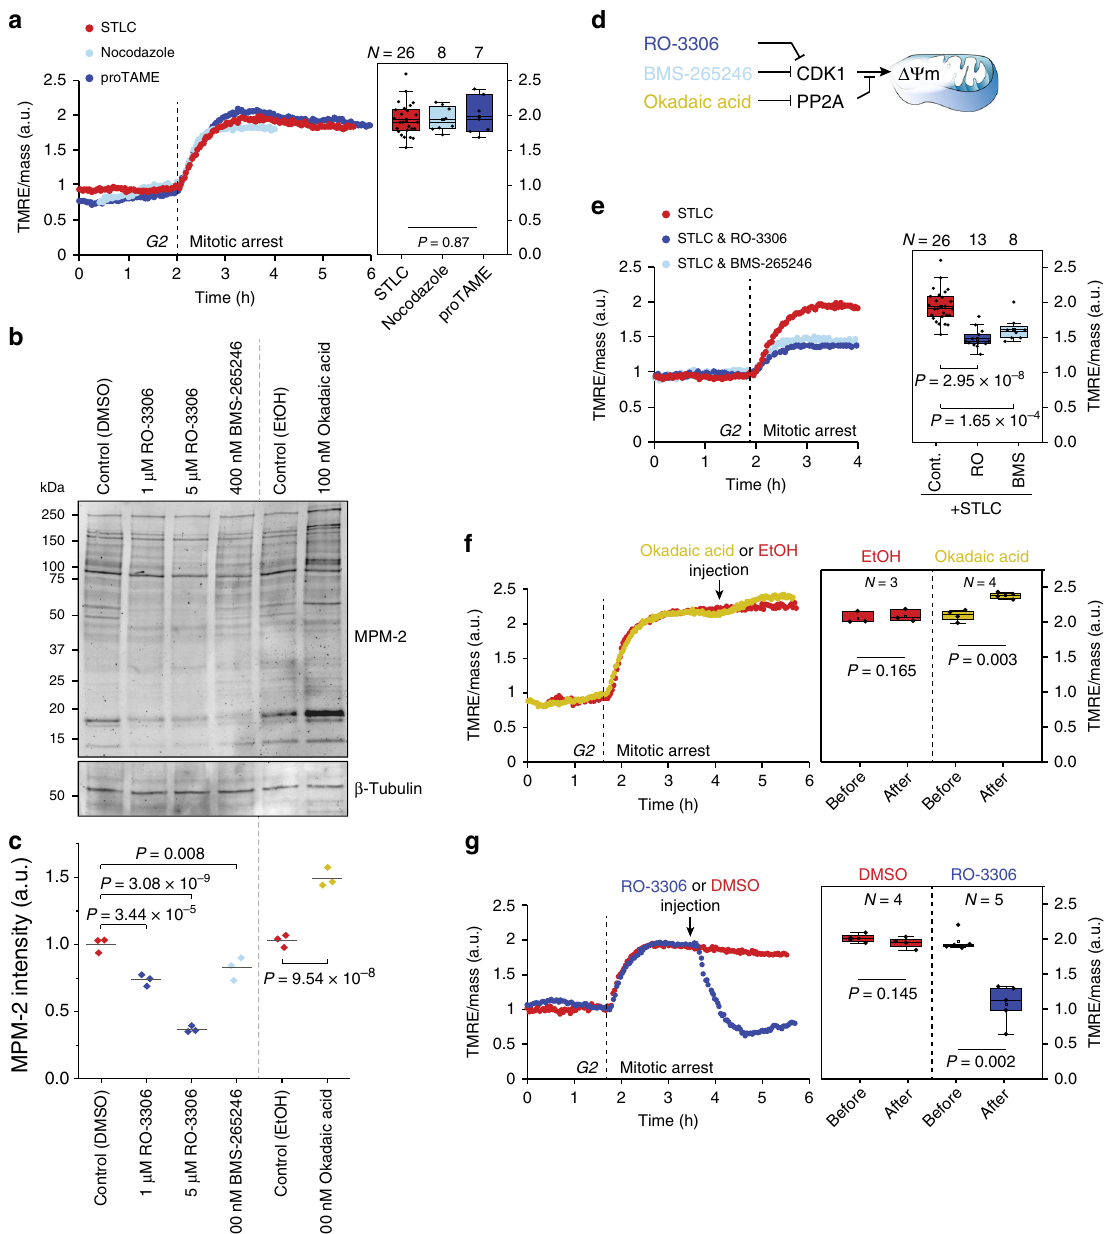
Fig. 2 CDK1 activity is required for the switch-like mitochondrial hyperpolarization. a Mass-normalized TMRE traces for L1210 cells treated with 5 µ M STLC (dark blue), 1 µ g/ml nocodazole (light blue), or 15 µ M proTAME (red) to induce mitotic arrest. TMRE signal reaches a stable but highly elevated level when mitosis is prolonged, indicative of a metabolic switch in mitosis. Boxplots show TMRE increases during mitotic arrest. Statistical signi fi cance was assessed using one-way ANOVA. b Western blot displaying CDK1 target phosphorylation levels using the MPM2 antibody. L1210 cells were treated for 30min, with indicated chemicals prior to lysis. β -tubulin was used as a loading control. c Flow-cytometer-based quanti fi cations of MPM2 antibody labeling. Samples were treated as in panel ( b ). Each dot represents a separate culture ( n = 3). d Schematic indicating how the chemical inhibitors affect CDK1 activity. e Mass- normalized TMRE traces for L1210 cells treated with 5 µ M STLC alone (red) or in combination with 1 µ M RO-3306 (dark blue) or with 400nM BMS-265246 (light blue) to partly inhibit CDK1. Partial inhibition of CDK1 reduces the extent of the metabolic switch in mitosis. Boxplots show TMRE increases during mitotic arrest. f Mass-normalized TMRE traces for a L1210 cell treated with 5 µ M STLC. Once the cell was arrested in mitosis, 100nM okadaic acid (yellow trace) or EtOH (control, 0.1% v/v, red trace) was injected (black arrow) to the culture media. Boxplots show TMRE levels before and after injection. g Mass-normalized TMRE trace for a L1210 cell treated with 5 µ M STLC. Once the cell was arrested in mitosis, 5 µ M RO-3306 (blue trace) or DMSO (control, 0.1% v/v, red trace) was injected (black arrow) to the culture media. Boxplots show TMRE levels before and after injection. Boxplots in ( a , e , f , g ) depict the mean (small square), median (horizontal bar), interquartile range (IQR) (box), and 1.5× IQR (whiskers). In ( a , e , f , g ), N represents independent experiments. Statistical signi fi cance was assessed using one-way ANOVA followed by Sidakholm test in ( c , e ), or paired, two-tailed Student ’ s t tests ( f , g